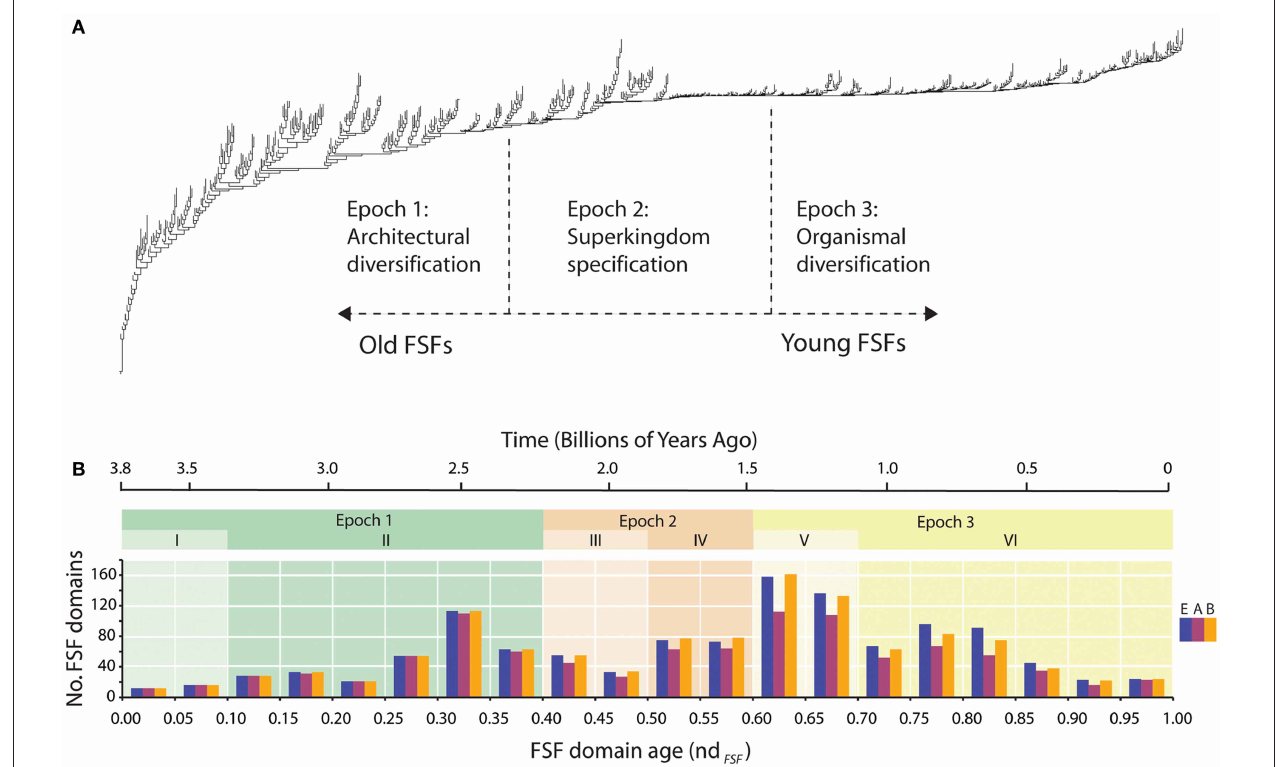
FIGURE 2 | Phylogenetic trees of protein domain structures. Phylogenetic trees of protein domain structures. (A) A tree describing the evolution of groups of domains was reconstructed from a genomic census of domains in hundreds of genomes. The approach was reviewed in Caetano-Anollés et al. (2009a). The leaves of the tree (taxa) are FSFs. The distribution of FSFs among superkingdoms Eukarya (E), Archaea (A), and Bacteria (B) is remarkably consistent (Wang et al., 2007; Wang and Caetano-Anollés, 2009). The most ancient FSFs are present in all organisms, but as time unfolds, FSFs are first lost in emerging archaeal lineages, and then in eukaryal and bacterial lineages. Superkingdom-specificFSFs only appear quite late in evolution. This “taxonomic” distribution of FSFs in life define the three epochs of the protein world that are mapped to the tree: Epoch 1, a period in which ancient molecules emerged and diversified while keeping proteomes similar to each other in a largely communal world; Epoch 2, a period in which molecules sorted in emerging organismal lineages and some became specific to emerging superkingdoms; and Epoch 3, a time in proteome